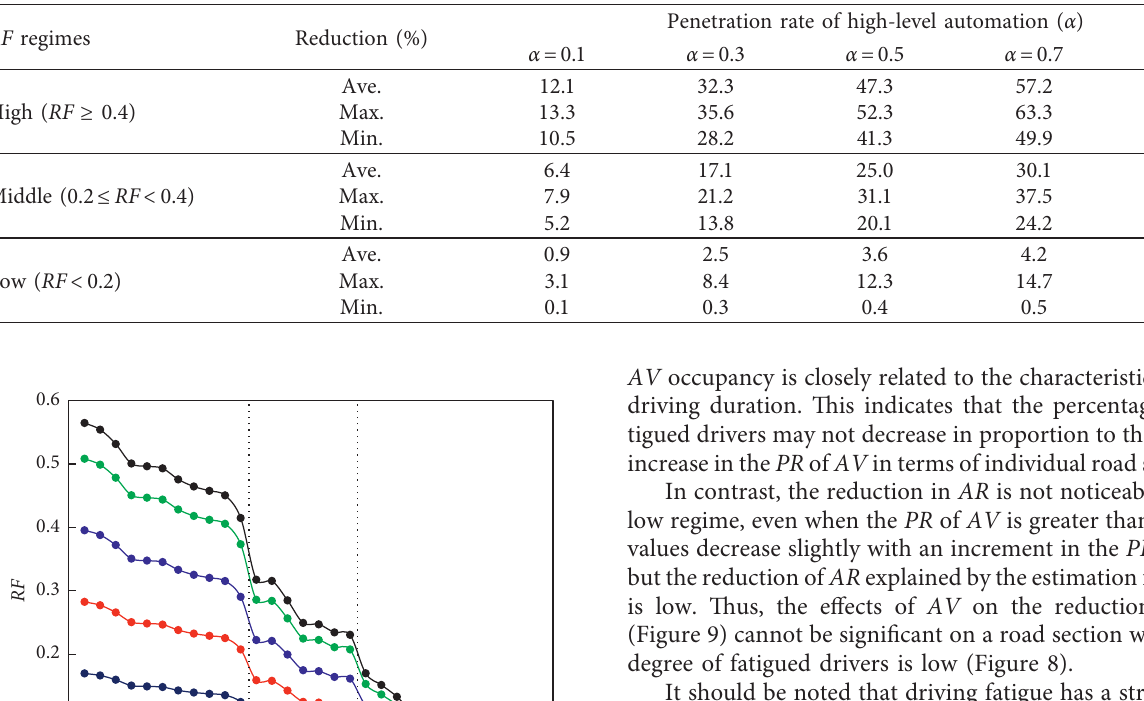
Table 1: Summary of the effects of high-level AV on the reduction of AR .